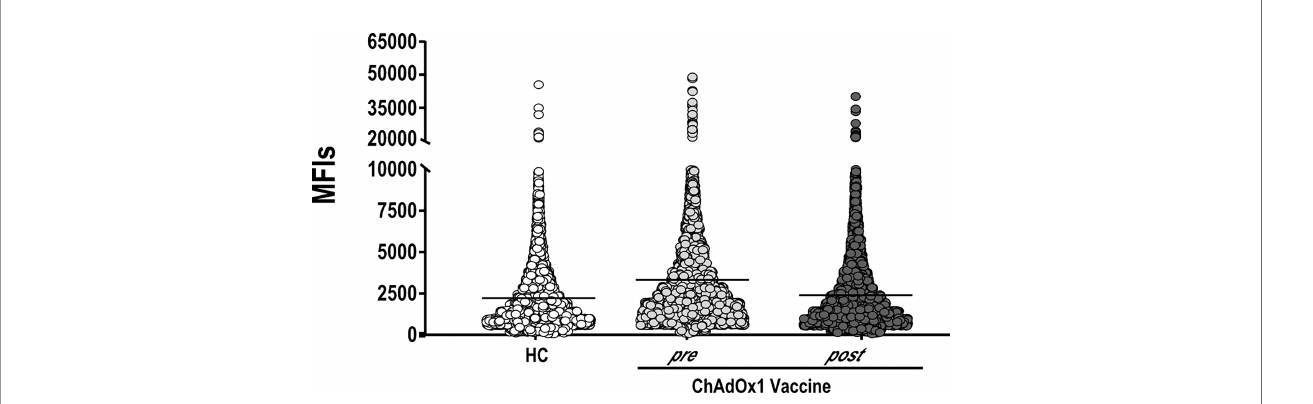
FIGURE 2 | ChAdOx1 vaccination does not alter the general autoimmunoreactivity. Mean Fluorescence Intensities values (MFIs) of all proteins spotted on the HuProt array probed with sera of ChAdOx1 individuals at pre- ( n = 10) and post-vaccination ( n = 15) and 10 Healthy Controls (HC). Each dot represents the MFI of a single protein within the groups of sera reported on the x -axis.